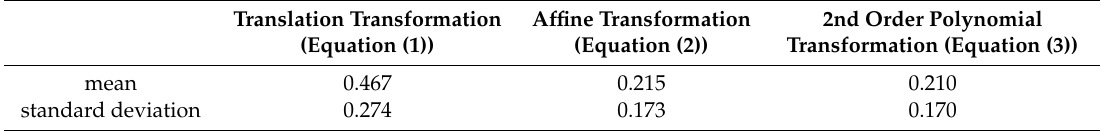
Figure 9. Dense-matching prediction-error maps for the translation ( a ); affine ( b ); and second order polynomial ( c ) transformations, between the Limpopo Landsat-8 week 49 and Sentinel-2A week 49 image pair. Table 8. Summary statistics (units 10 m pixels) of the dense-matching prediction error (Equation (7)) for the translation, affine and polynomial transformations obtained from the Limpopo image